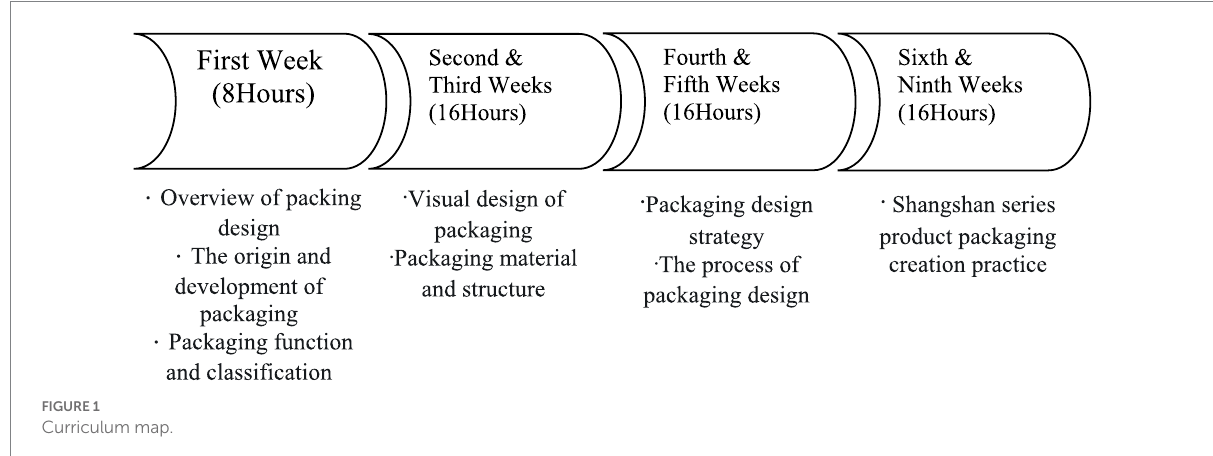
FIGURE 1 Curriculum